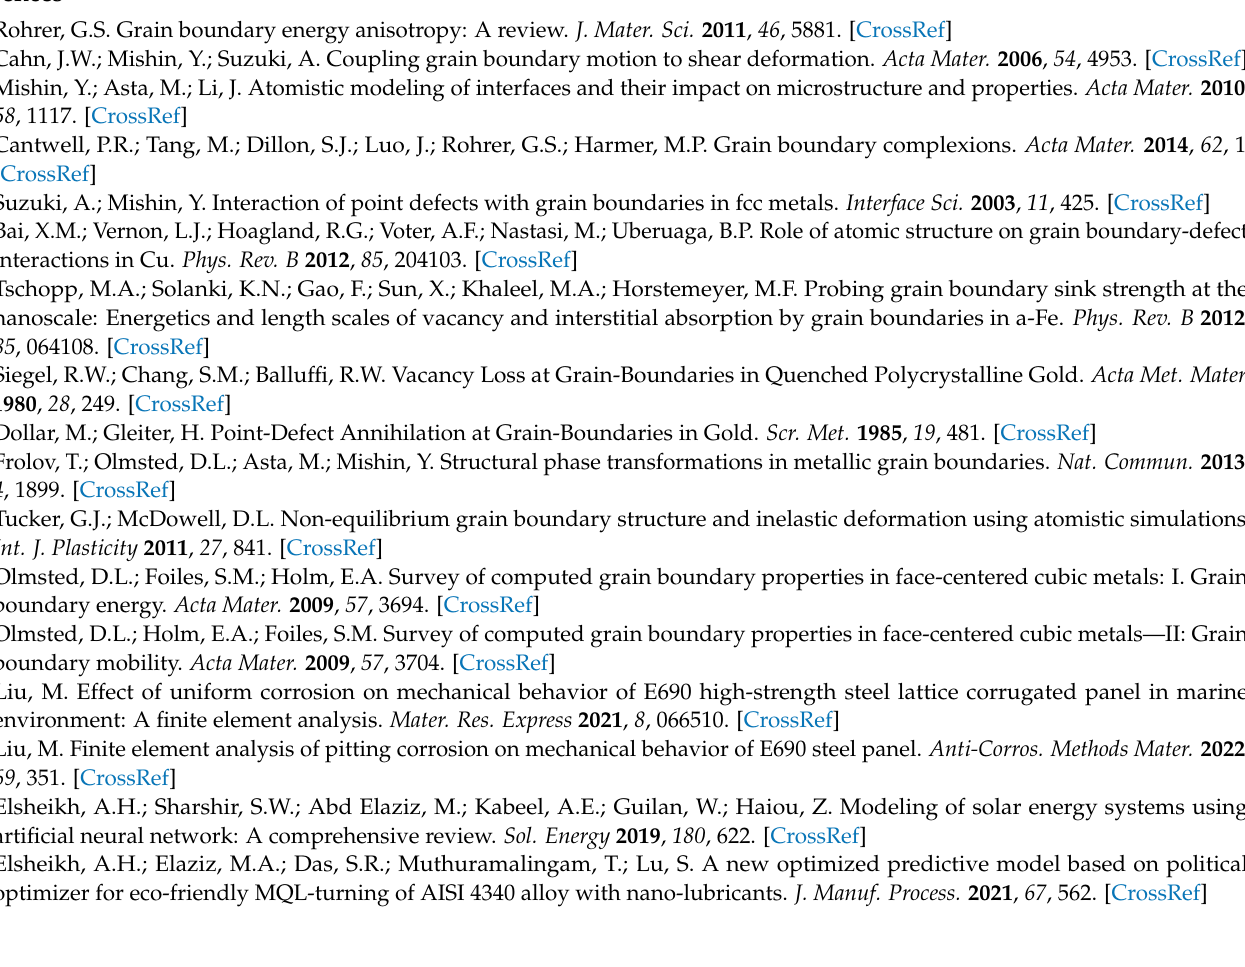
GBs for three methods of selecting GB atoms. Figure S16. PCA based prediction results of Ni <110> GBs using partitioned <110> data. Regression is performed using PCi based on dimensionality reduction and further interpolation as a function of φ , respectively. Figure S17. PCA based prediction results of Ni <100> GBs using portioned <100> data. Regression is performed using PCi based on dimensionality reduction and further interpolation as a function of φ , respectively. Figure S18. Comparison of Computed PCi with cubic interpolated PCi as a function of inclination angle for <100> type Ni GBs. Figure S19. Comparison of computed PCi with cubic interpolated PCi as a function of inclination angle for <100> type Ni GBs. Figure S20. MRE of Cu GBs for three methods of selecting GB atoms. Figure S21. MAE convergence curve for RNN prediction of Cu GBs. Table S1. Some additional information of all GB models. Table S2. Variation range of GB energies for all GBs of each metal (mJ/m 2 ). Table S3. Some material constants and parameter used for computing PCF. Table S4. Cubic interpolation of PCi as a function of inclination angle for all Cu GBs. Table S5. Cubic interpolation of PCi as a function of inclination angle for all Al GBs. Table S6. Cubic interpolation of PCi as a function of inclination angle for all Ni